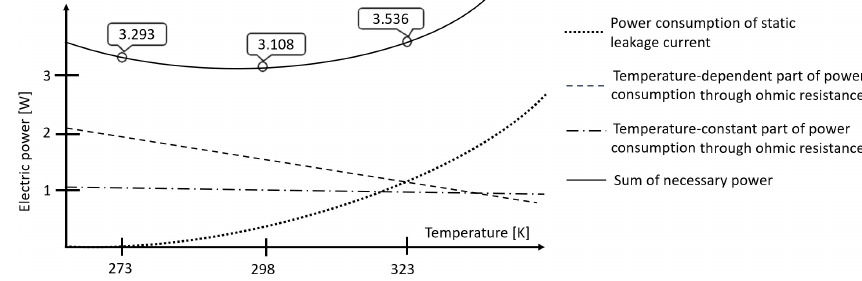
Figure 10. Estimation of the power